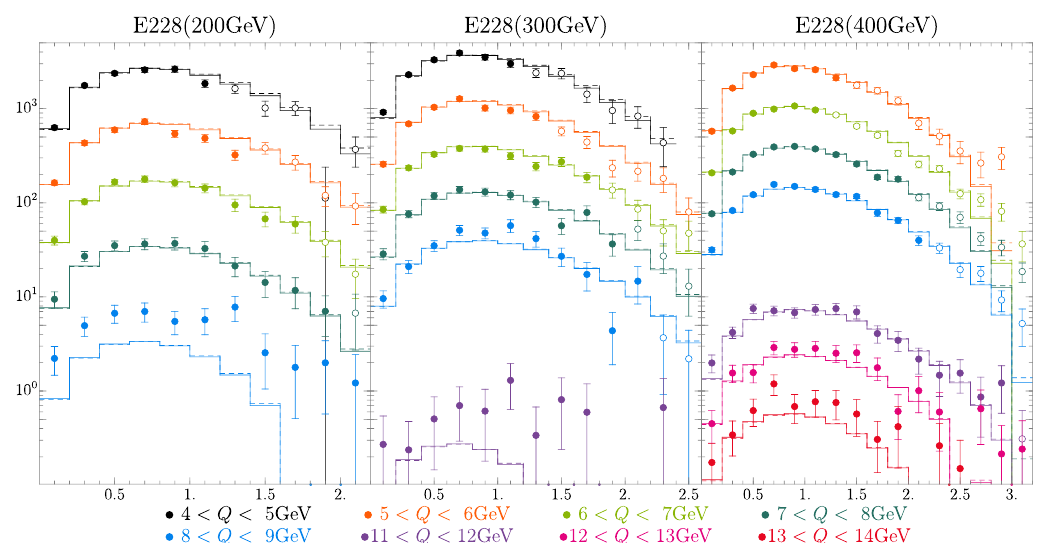
Figure 15 . Di(cid:11)erential cross-section of DY process ( d(cid:27)=dq T [fb/GeV] vs. q T [GeV]) measured by E288 at di(cid:11)erent values of s and Q . The solid (dashed) lines are the theory prediction at NNLO (N 3 LO) shifted by the average systematic shift (see table 8). Filled (empty) point were (not) included in the (cid:12)t of NP parameters.